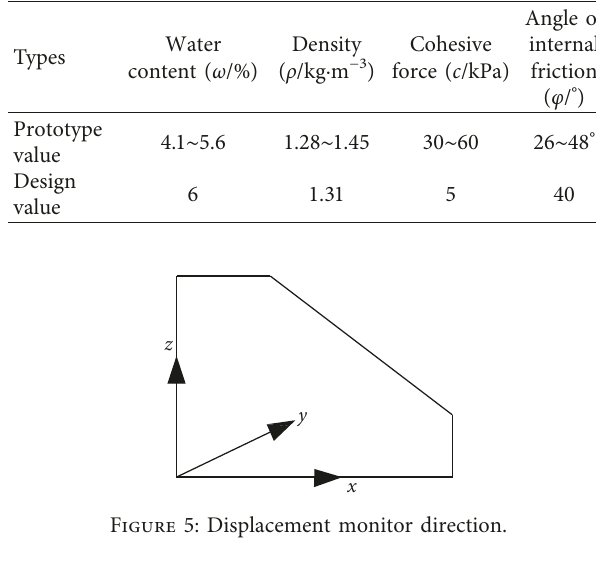
Figure 5: Displacement monitor direction.